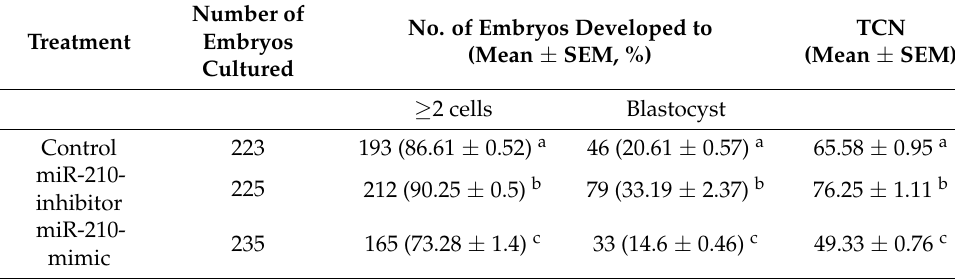
Table 3. Effects of miR-210 (inhibitor and mimic) treatment on porcine in vitro embryo development.